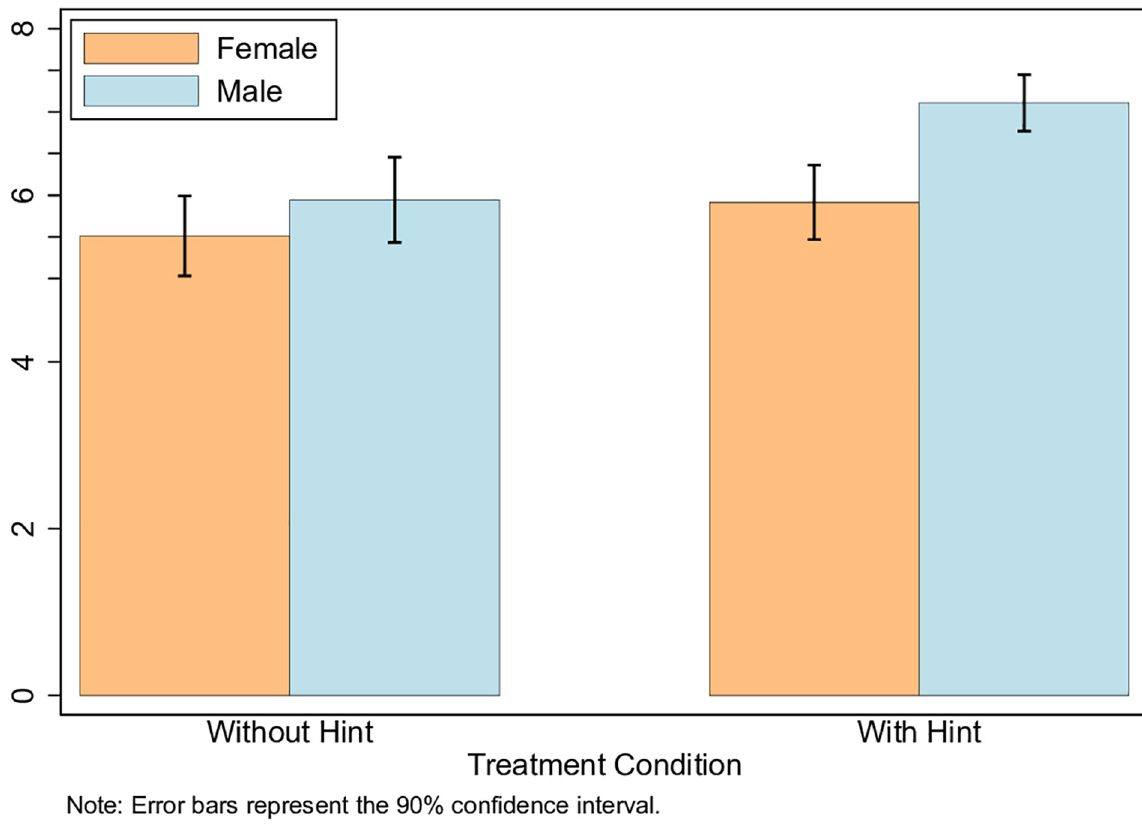
Fig 6. Self-evaluation of second stage performance by